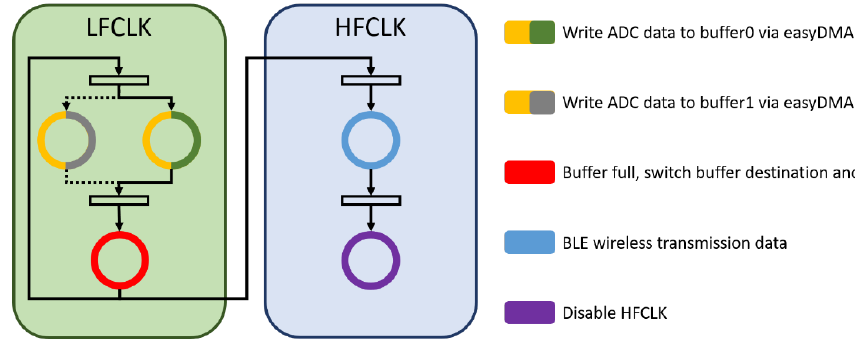
Figure 12. The proposed two MCU clock sources with ping-pong buffer architecture.